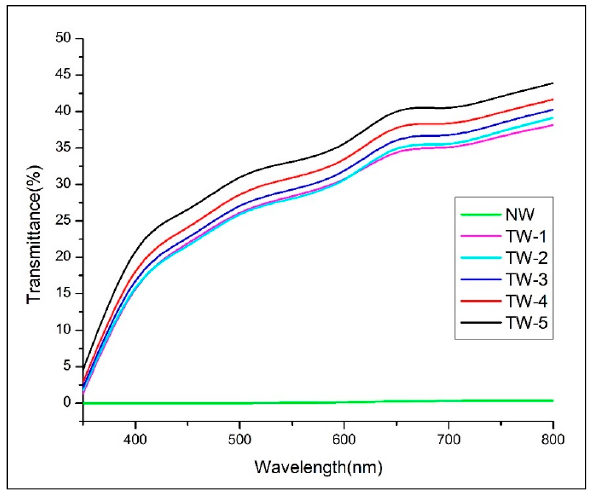
Figure 5. Optical transmittance of natural wood (NW) and transparent wood (TW) samples.